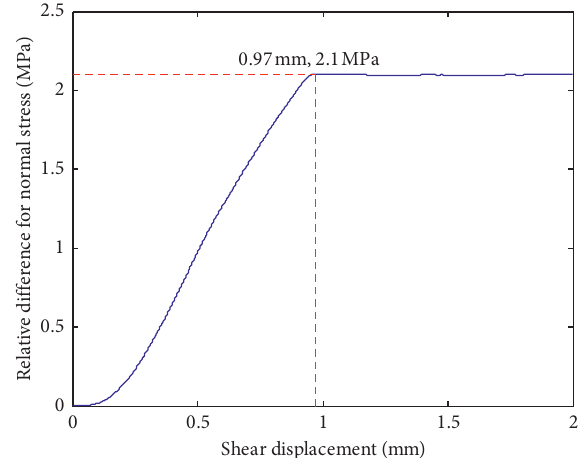
Figure 17: Variation of the relative difference of normal stresses in the numerical